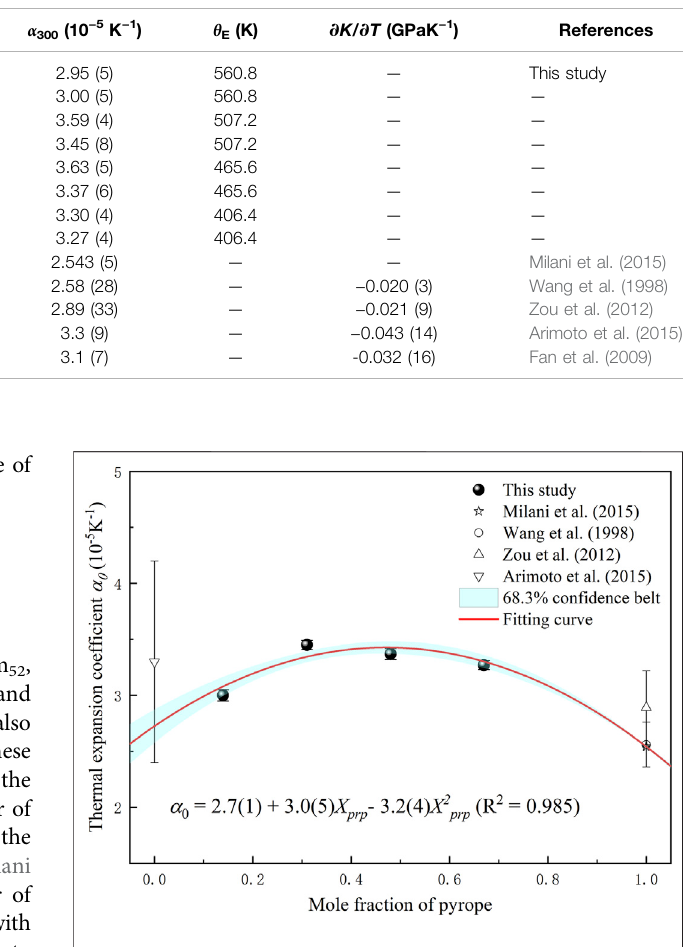
FIGURE5| Thethermalexpansioncoef fi cientofpyrope-almandinesolid solution garnet at 300 K as a function of pyrope